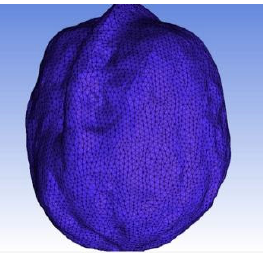
Figure 11. Meshing of the walnut model.